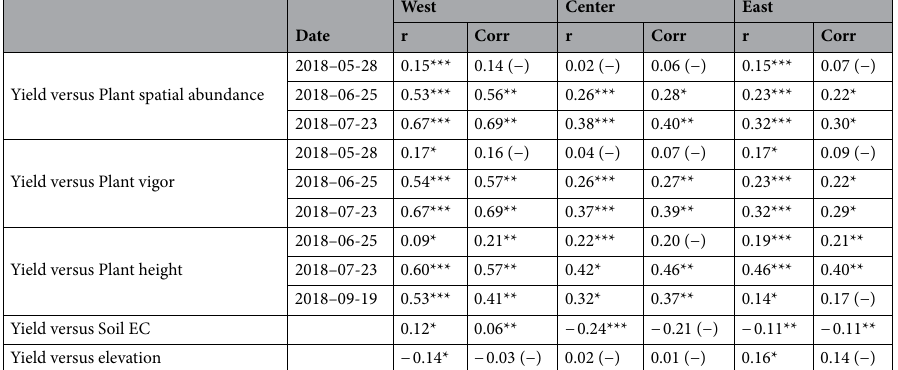
Table 3. Pearson’s (r) and corrected Pearson’s (corr) coefficients computed between the yield, plant properties, soil EC a , and elevation. The table reports the correlations computed for the east, center, and west areas. Statistical significance is given by * p < .05, ** p < .01, *** p < .001, (−) for non